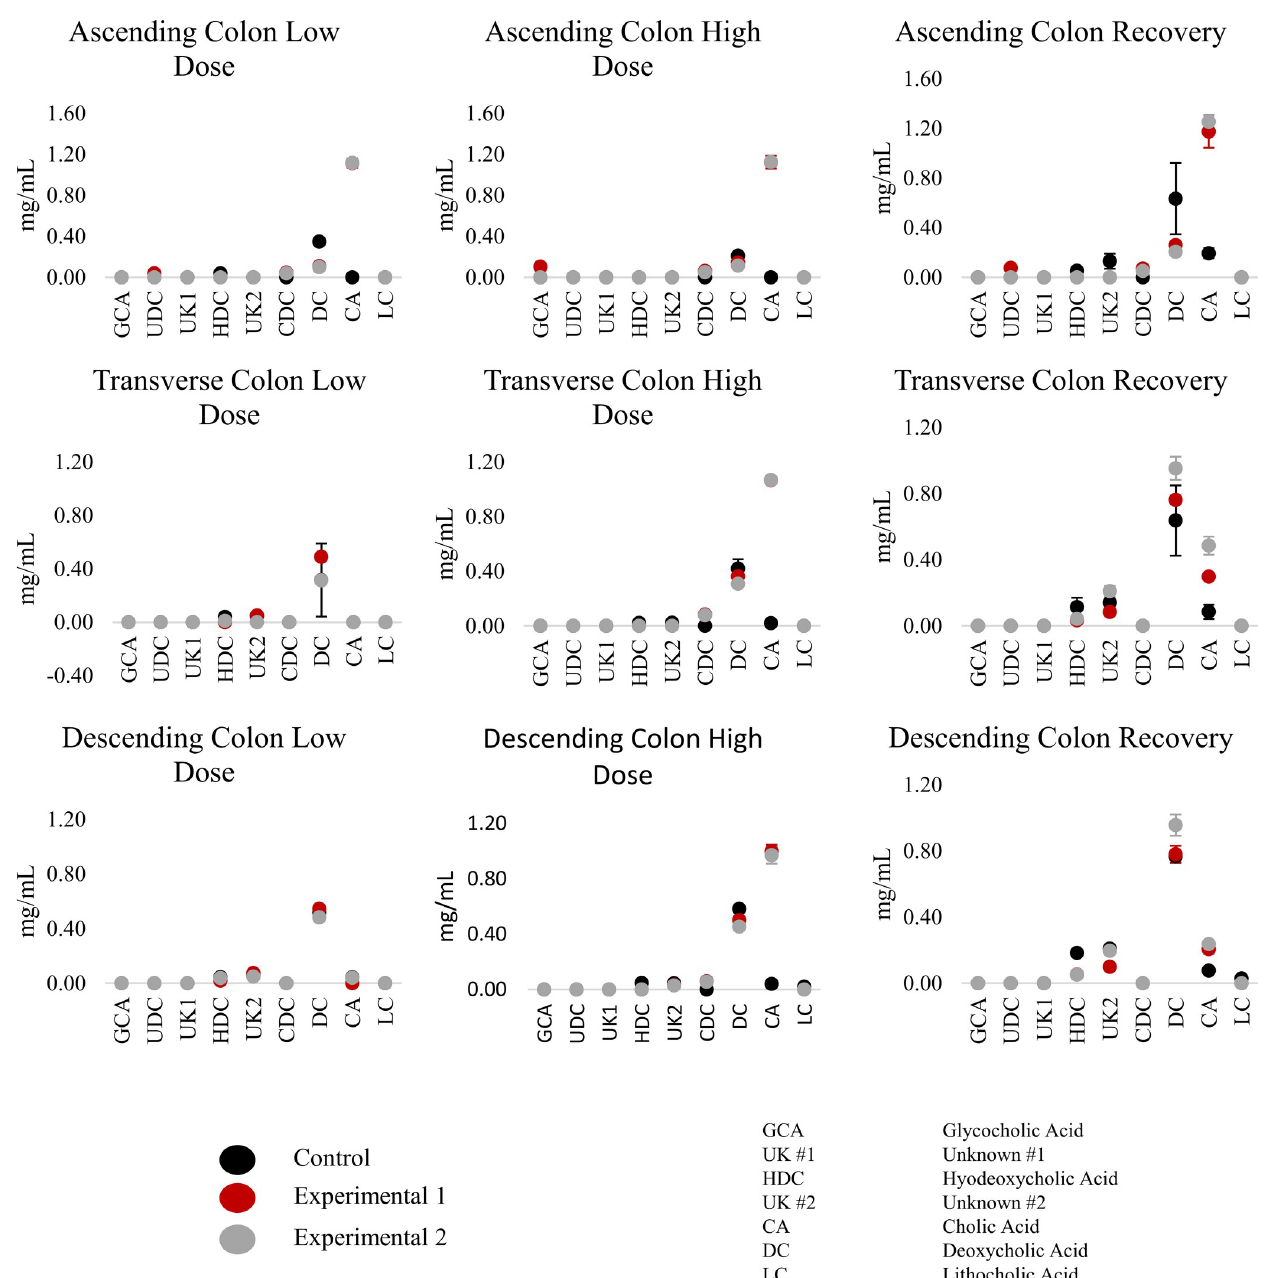
Fig 7. Bile acid concentration at the end of each experimental phase. Error bars are based on standard deviation.